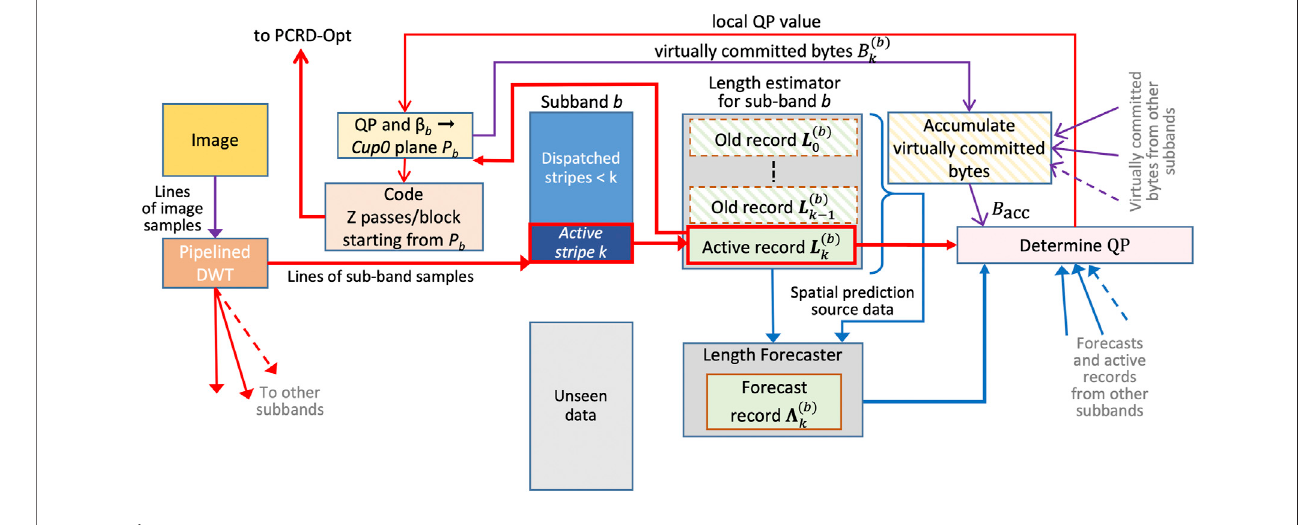
FIGURE 7 | Forecast-based incremental CPLEX-based encoding.